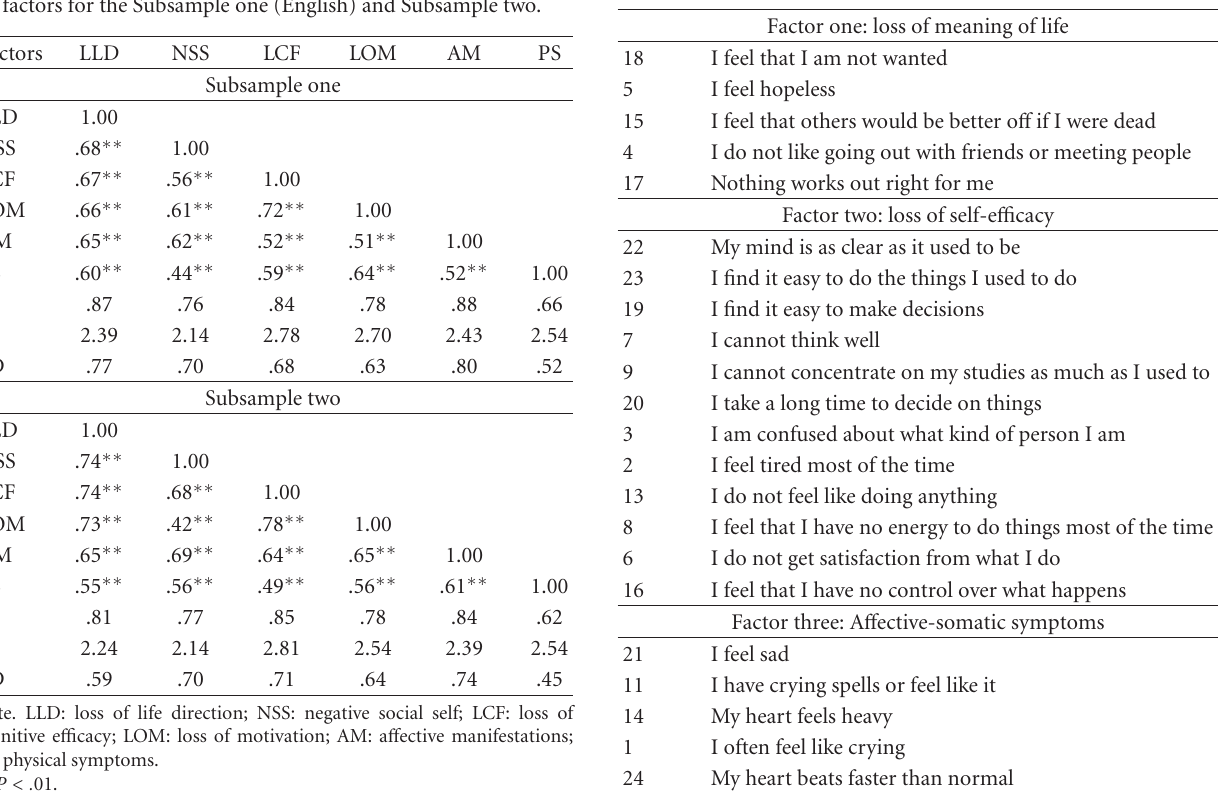
Table 4: The Asian Depression